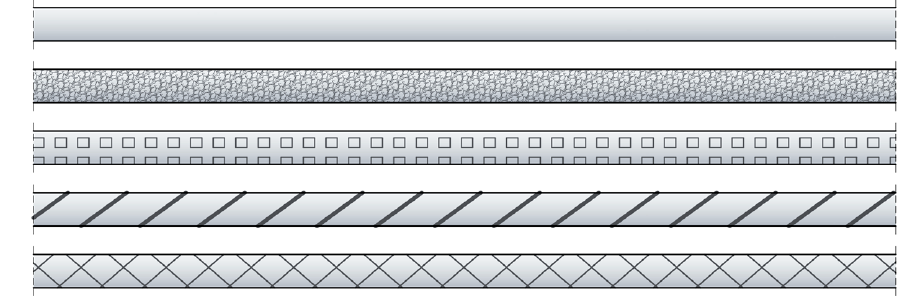
Figure 8. Example ideas for the outer surface of the DFOS tool (from top): smooth, with sand grains, with perforated groves, with unidirectional thick braid, with bidirectional thin braid.